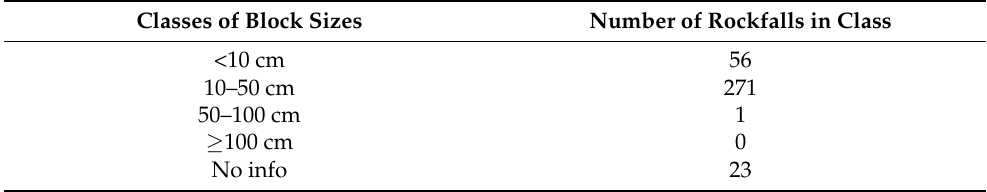
Table 1. Block size characteristics of rockfall events. Block sizes indicate the maximum edge